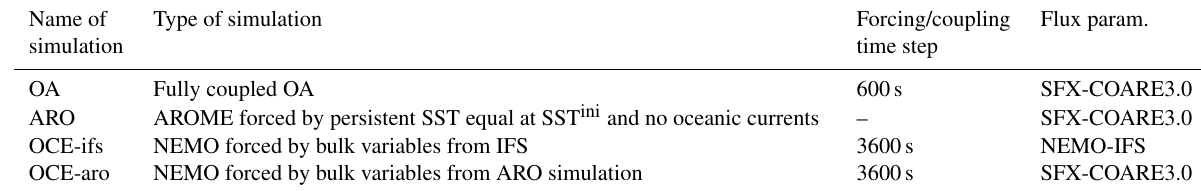
Table 2. Set of simulations.